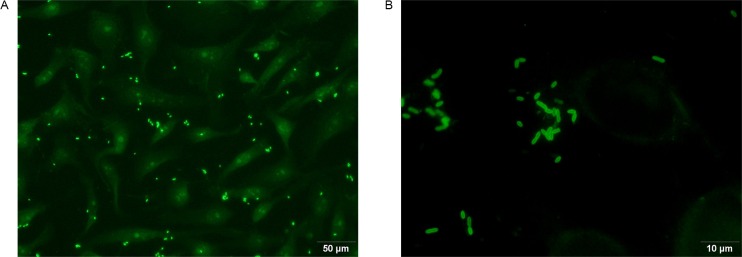
Example of a positive IFA test.A) 20X objective and 10X oculars. B) 100X objective and 10X oculars.